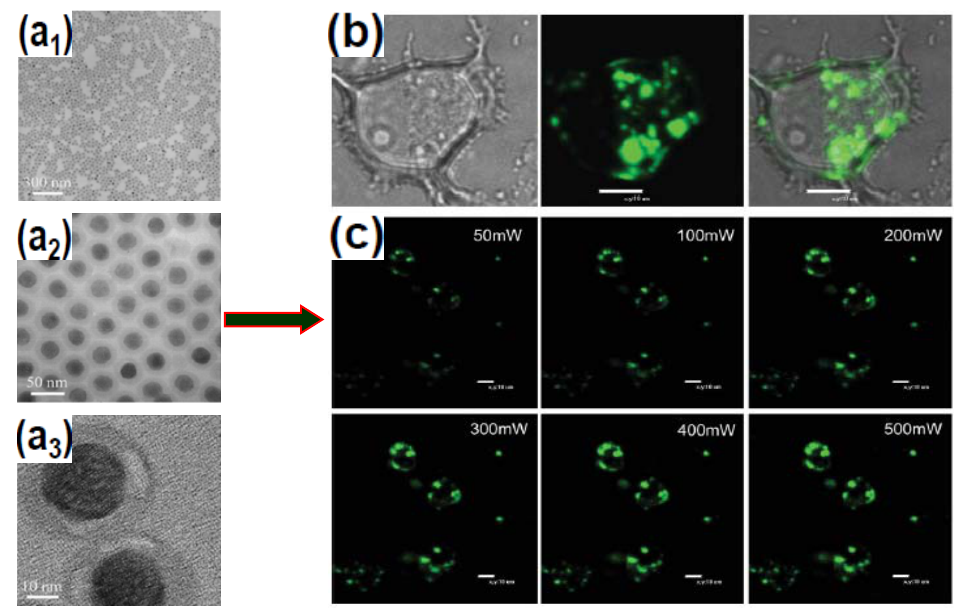
Figure 8. Silica-coated NaYF 4 :Yb/Er nanocrystals and their application for cell imaging. ( a 1– a 3) TEM images of silica-coated NaYF 4 :Yb/Er UCNPs upconversion nanoparticles at different magnifications; ( b ) Confocal fluorescence image of MCF-7 cells using silica-coated NaYF 4 :Yb/Er nanospheres (Left: bright-field, middle: upconversion image under 980 nm excitation, and Right: superimposed images of MCF-7 cells incubated with the nanoparticles for 24 h); ( c ) Confocal fluorescence images of MCF-7 cells with the nanospheres, excited by a 980 nm laser with different power intensities.